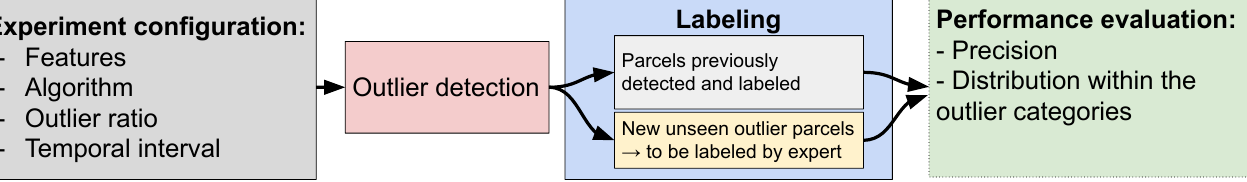
Figure 5. Diagram illustrating the idea behind the different conducted